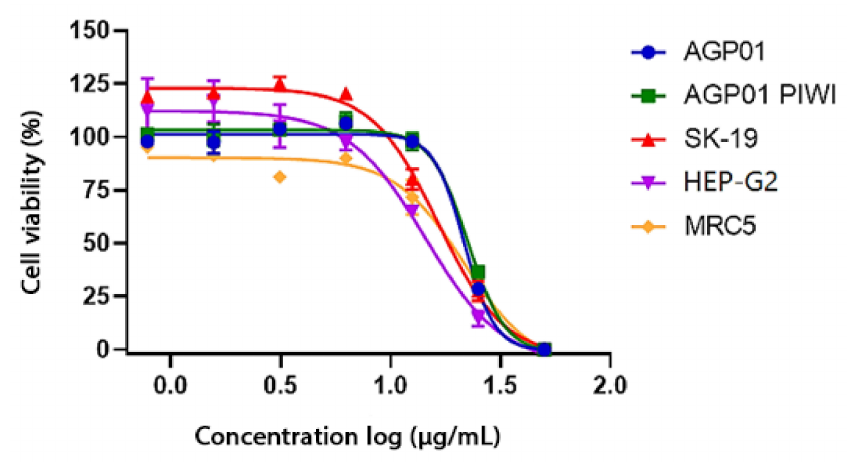
Figure 9. Percentage of cell proliferation after 72 h of treatment with piperine in different cell lines. Each point is equivalent to the average of three replicates.